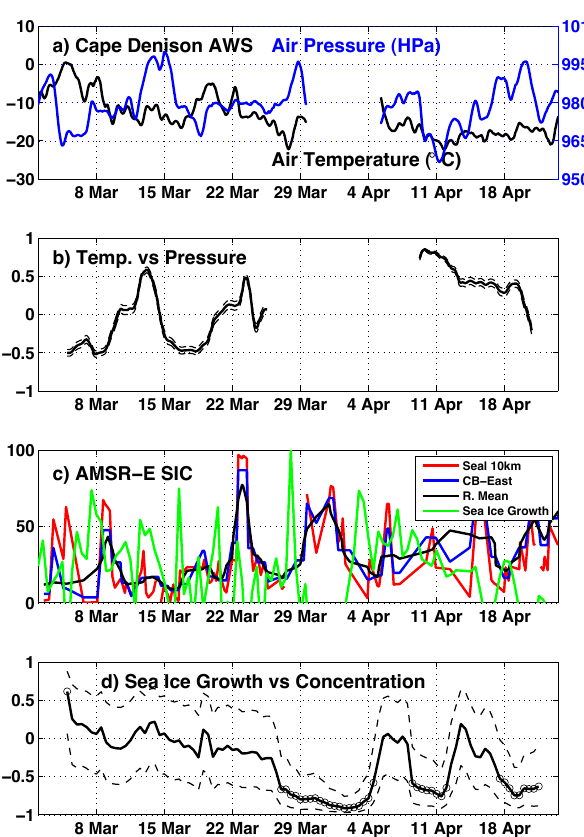
Fig. 11. Time series of: (a) AWS data from Cape Denison. Air pressure (HPa, blue, y-axis reversed) and air temperature ( ◦ C, black); (b) Running correlation (8-day window) between linearly de-trended air pressure and temperature. Dashed lines indicate 95% confidence level; (c) Sea ice concentration (%) with normalised sea ice growth rate estimates (%) from Fig. 10e (6–200m) shown in green. Colors indicated mean value within 10km radius of seal locations (red) and over the eastern sector of Commonwealth Bay (blue, with 4-day running mean in black). (d) Correlation coef- ficients between linearly de-trended sea ice growth (based on 6– 200m layer in Fig. 10e) and sea ice concentration (4-day running mean from Fig. 11c). Dashed lines indicate 95% confidence level. Open circles indicate significant correlations ( p < 0 .